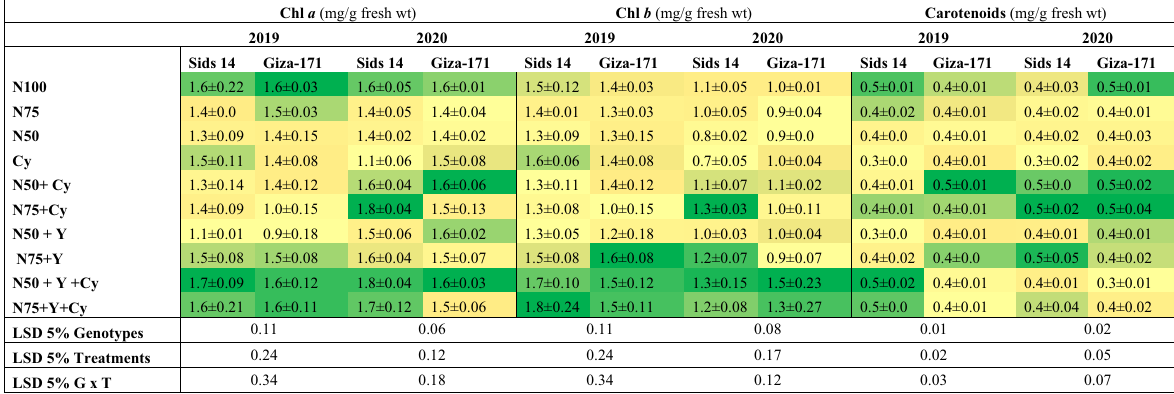
Table 2 Interactive effect of cyanobacteria (Cy), yeast (Y) inoculation and mineral fertilization (N; nitrogen dose) on pigments content of wheat plant after 65 days of germination during two consecutive seasons 2019 and 2020. The color scale pattern was generated in Excel, lower values are denoted in yellow color, whereas higher values are depicted by a green color. Each value is mean of 3 independent replicates SE ±